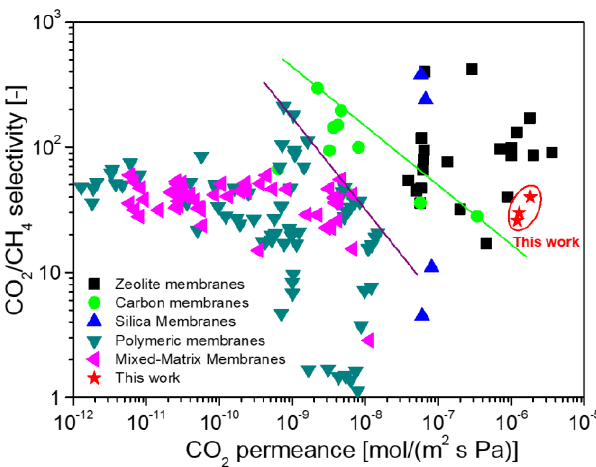
Figure 19. Comparison of separation performance of various types of membranes for CO 2 /CH 4 at or around room temperature. Reprinted from [72] with permission from Elsevier.